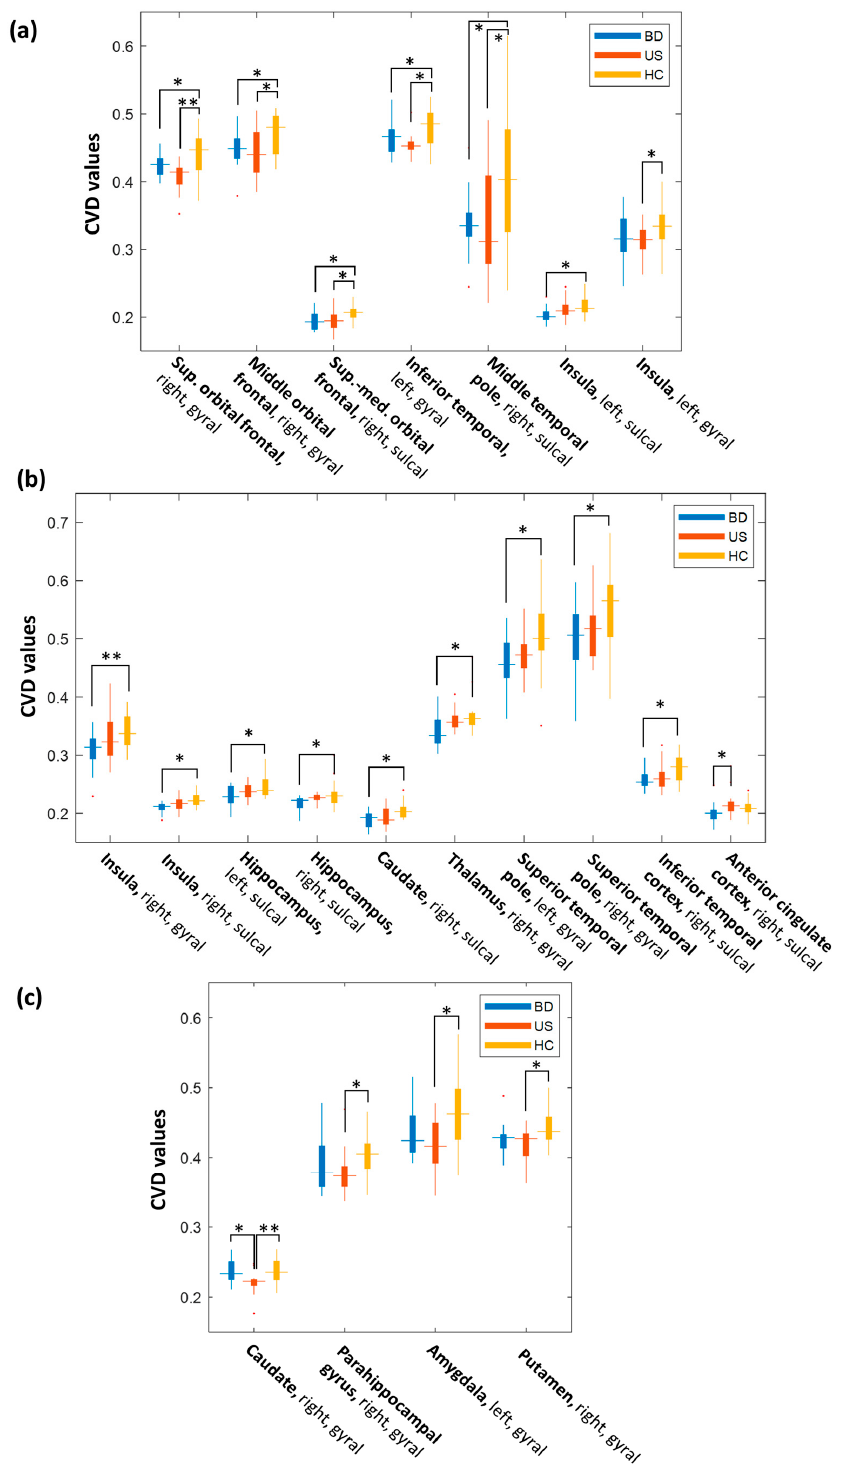
Figure 3. Boxplots for illustrating the group differences in CVD values between BD patients, unaffected siblings, and healthy controls. ( a ) Significant differences in both BD patients and unaffected siblings compared with healthy controls (as listed in Table 2); ( b ) significant differences in BD patients compared with healthy controls and unaffected siblings (as listed in Table 3); ( c ) significant di ff erences in una ff ected siblings compared with healthy controls and BD patients (as listed in Table